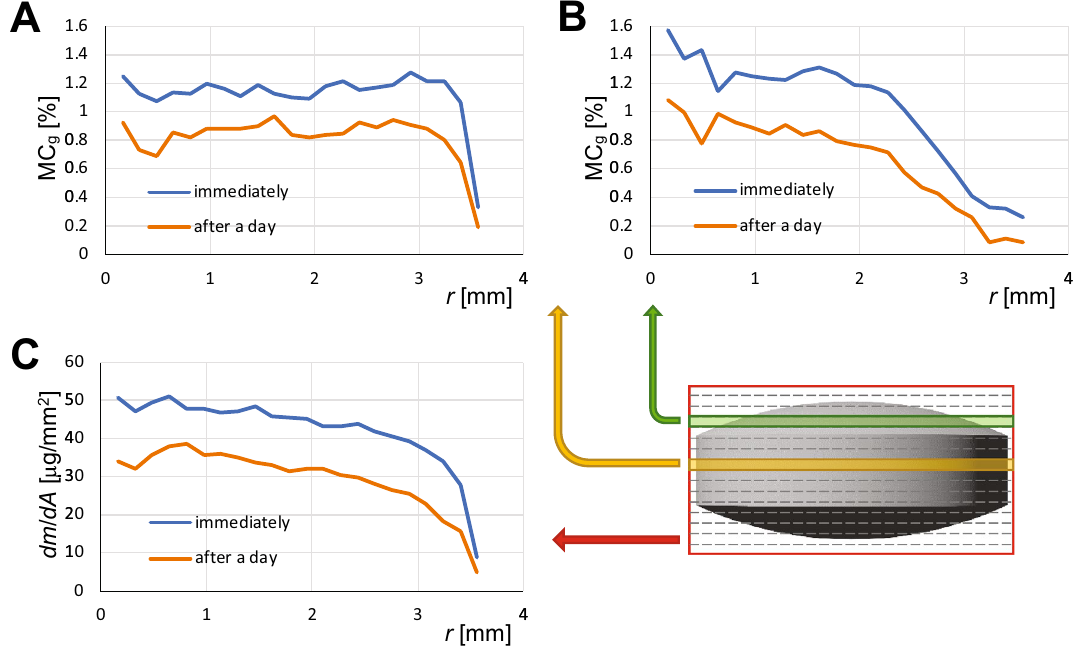
Figure 5. Radial profiles of moisture distribution in an average tablet. ( A ) and ( B ) radial profiles of gravimetric moisture content for central and off-center slice, respectively. ( C ) radial profile of water area density of the average tablet. Moisture distribution profiles correspond to tablets immediately after moistening (in blue) or after a day (in